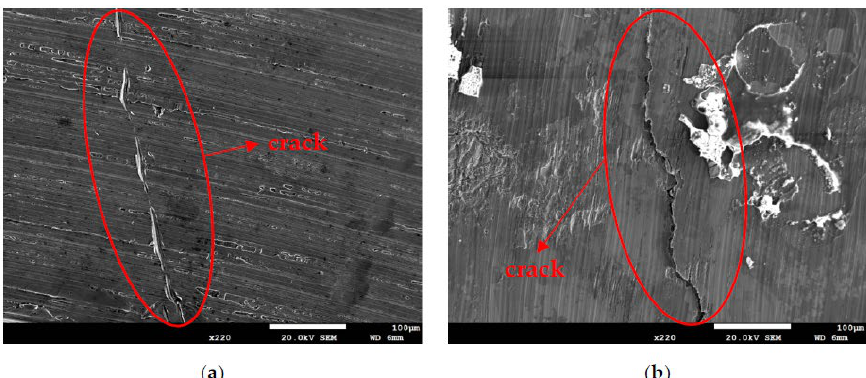
Figure 11. SEM morphology of the SCC in those samples with a chloride concentration of 1 g/m 2 after 7000 h of testing at: ( a ) RH = 55% and ( b ) RH = 70%. Figure 12 demonstrates EDS mapping for the crack regions of those samples depos- ited with a 1 g/m 2 chloride concentration tested at a 70% RH. The crack region is obviously enriched with chlorine and oxygen, as respectively demonstrated by Figure 12e,f, but de-